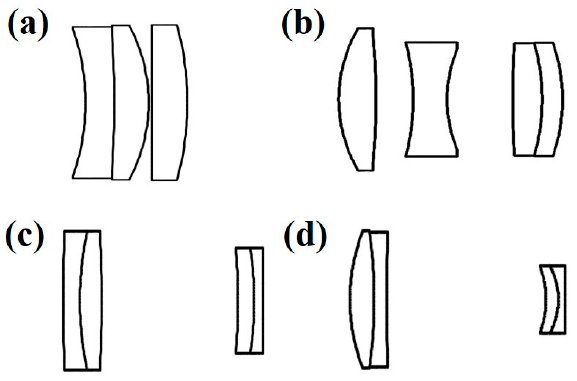
Figure 2. Initial structure of the optical system. ( a ) Structure of the doublet–singlet lens for the front objective. ( b ) Three-component objective as the initial structure of the photographic lens. ( c , d ) The initial structures of Galilean telescopes with 25× and 40× magnification, respectively.